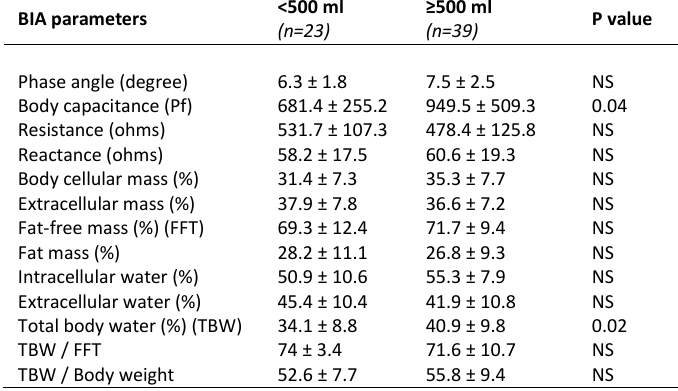
Table 4: Comparison of bioimpedance parameters post implantation by amount of fluids during surgery (right side) BIA